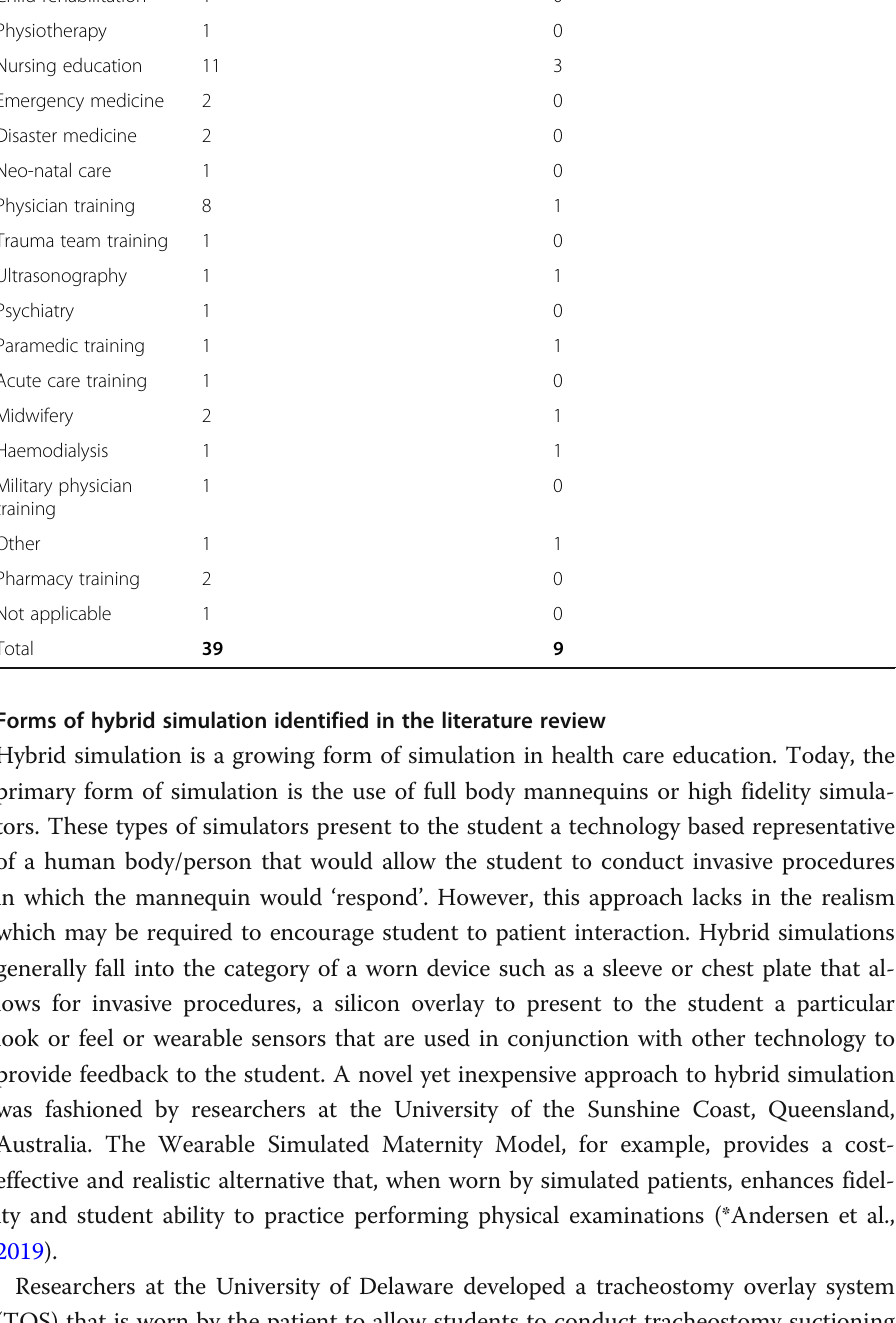
Health care disciplines represented – phase